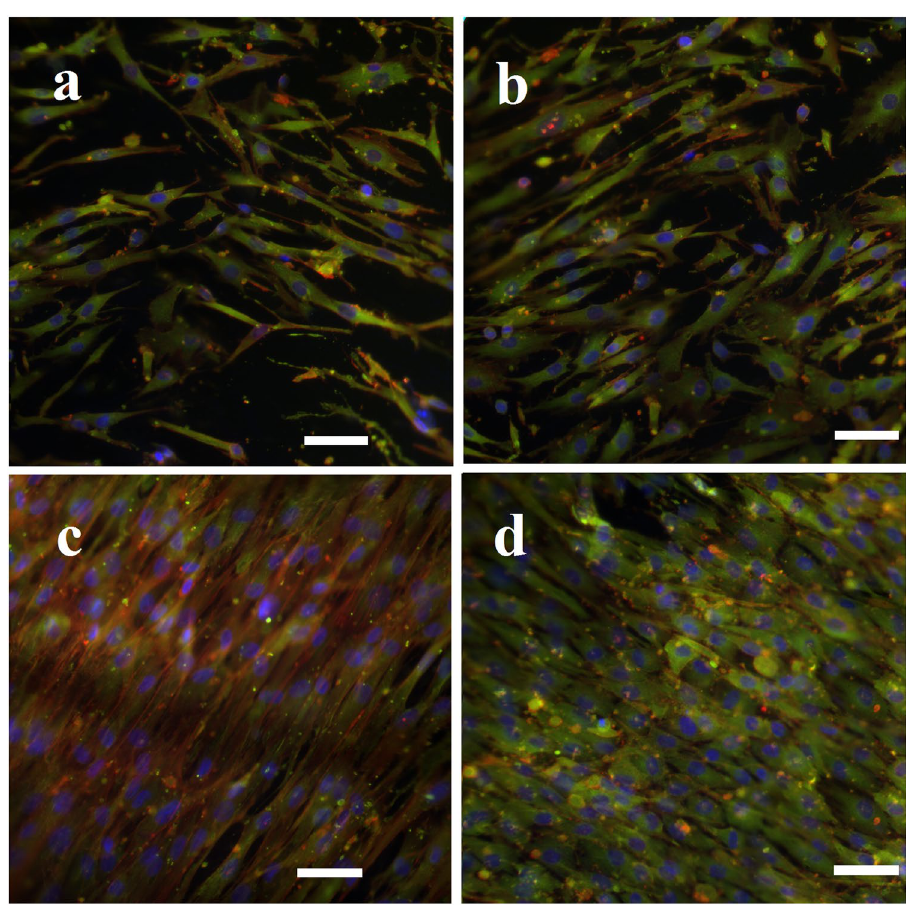
Figure 7. Morphology of rabbit MSCs on PBSGL nanofibers (PBSGL0 ( a ), PBSGL10 ( b ), BSGL20 ( c ) and PBSGL40 ( d )) seeded at a cell density of 4000 cells per cm 2 after 7 days’ culture. Cells were immuno-stained with an antibody against vinculin (green), FITC–phalloidin (red), and DAPI (blue). Scale bar = 100 μ